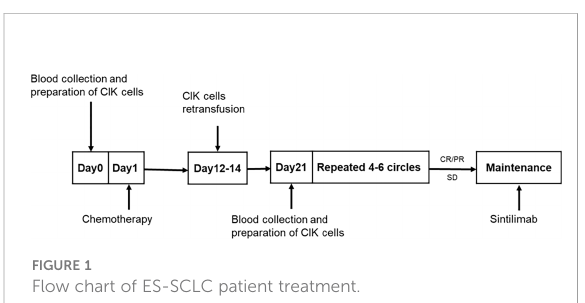
FIGURE 1 Flow chart of ES-SCLC patient